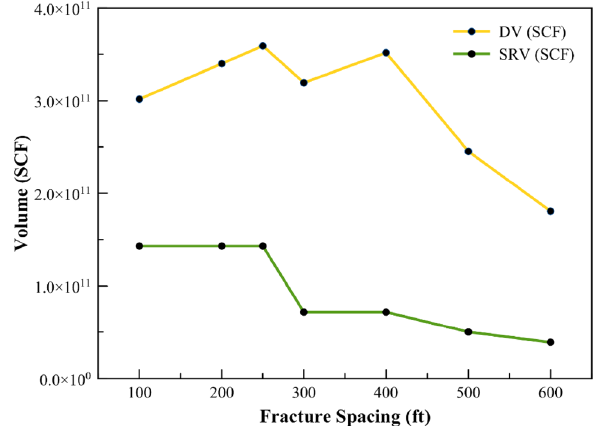
Fig. 10 SRV-DV Comparison of fracture-spacing